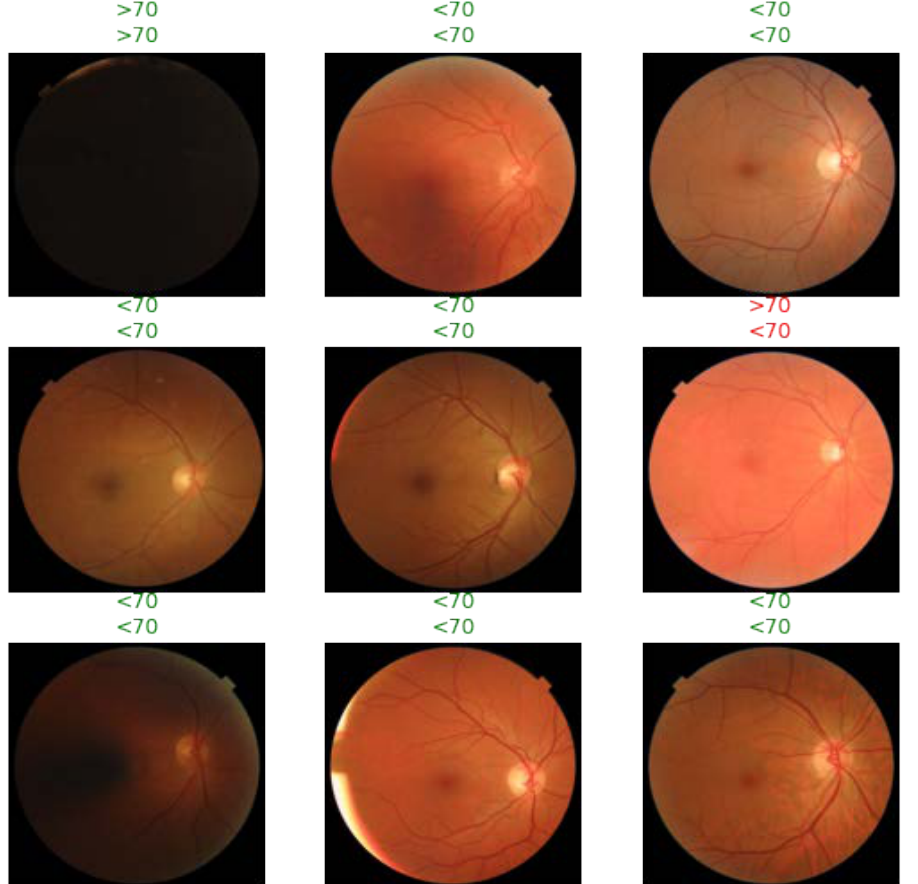
Figure 1. Representative fundus imaging with age > 70 ground-truth labeling and ImageNet-pretrained model classification. Above each fundus image, the first row of data contain the ground truth extracted from patient EMR and the second row contains the AI model pre-trained on ImageNet’s classification. Green and red indicate agreement and disagreement between the AI model and ground truth, respectively. For example, the fundus image in the top row on the far right was correctly predicted to be from a patient under 70 years of age (see the concordance between the ground truth and AI classification), whereas the fundus image in the second row far right was incorrectly predicted by the AI model.